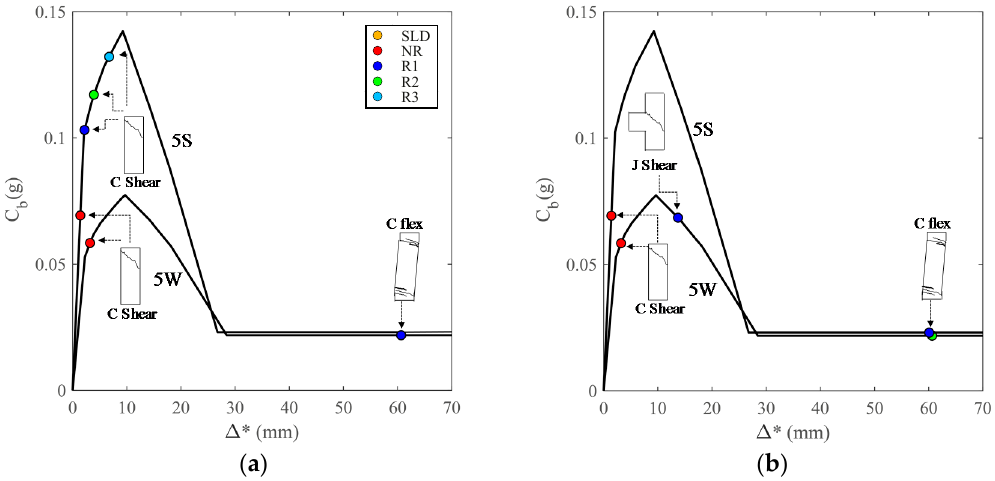
Figure 9. Pushover curves for 5W and 5S configurations and failure mechanisms for the NR and ( a ) R1, R2, and R3 FRP-only retrofit solutions and ( b ) R1, R2, and R3 FRP + SRP retrofit solutions.